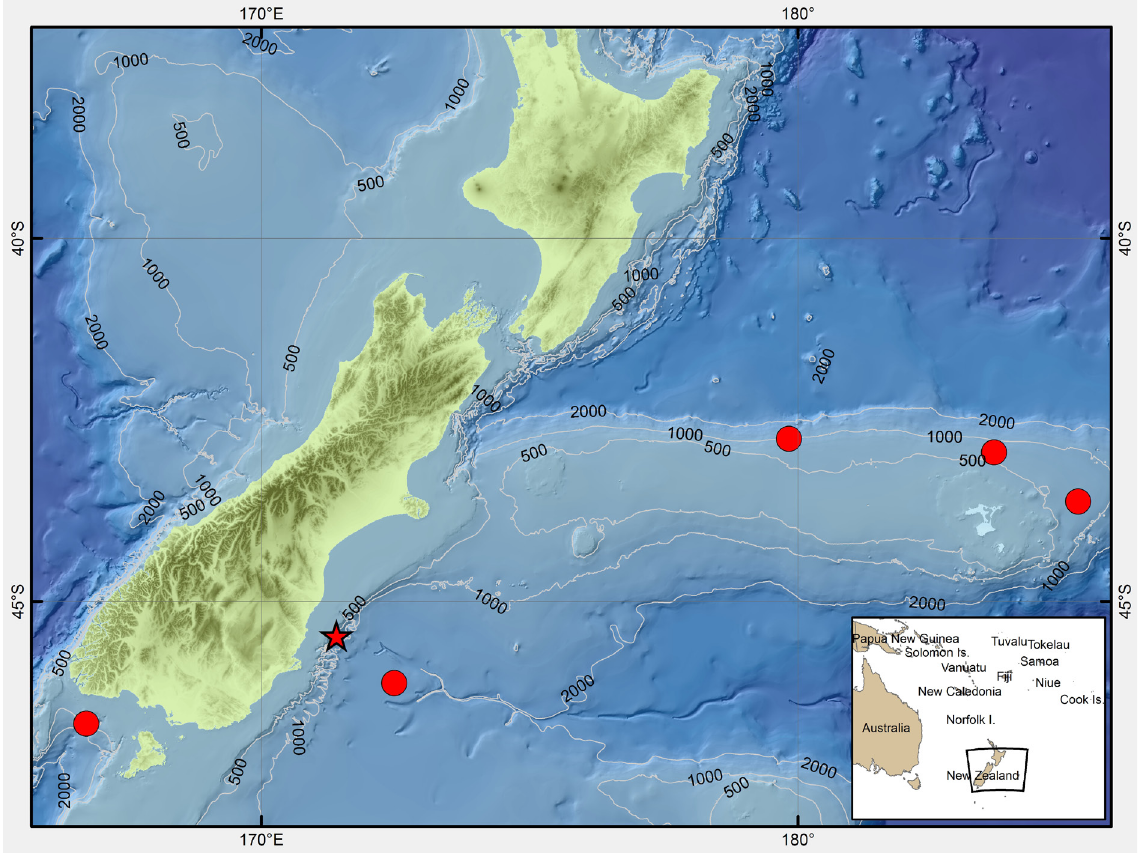
Fig. 1. Sampling localities of the calwelliid bryozoan Onchoporoides moseleyi harboring Bryoconversor tutus gen. et sp. nov. The type locality is indicated by a